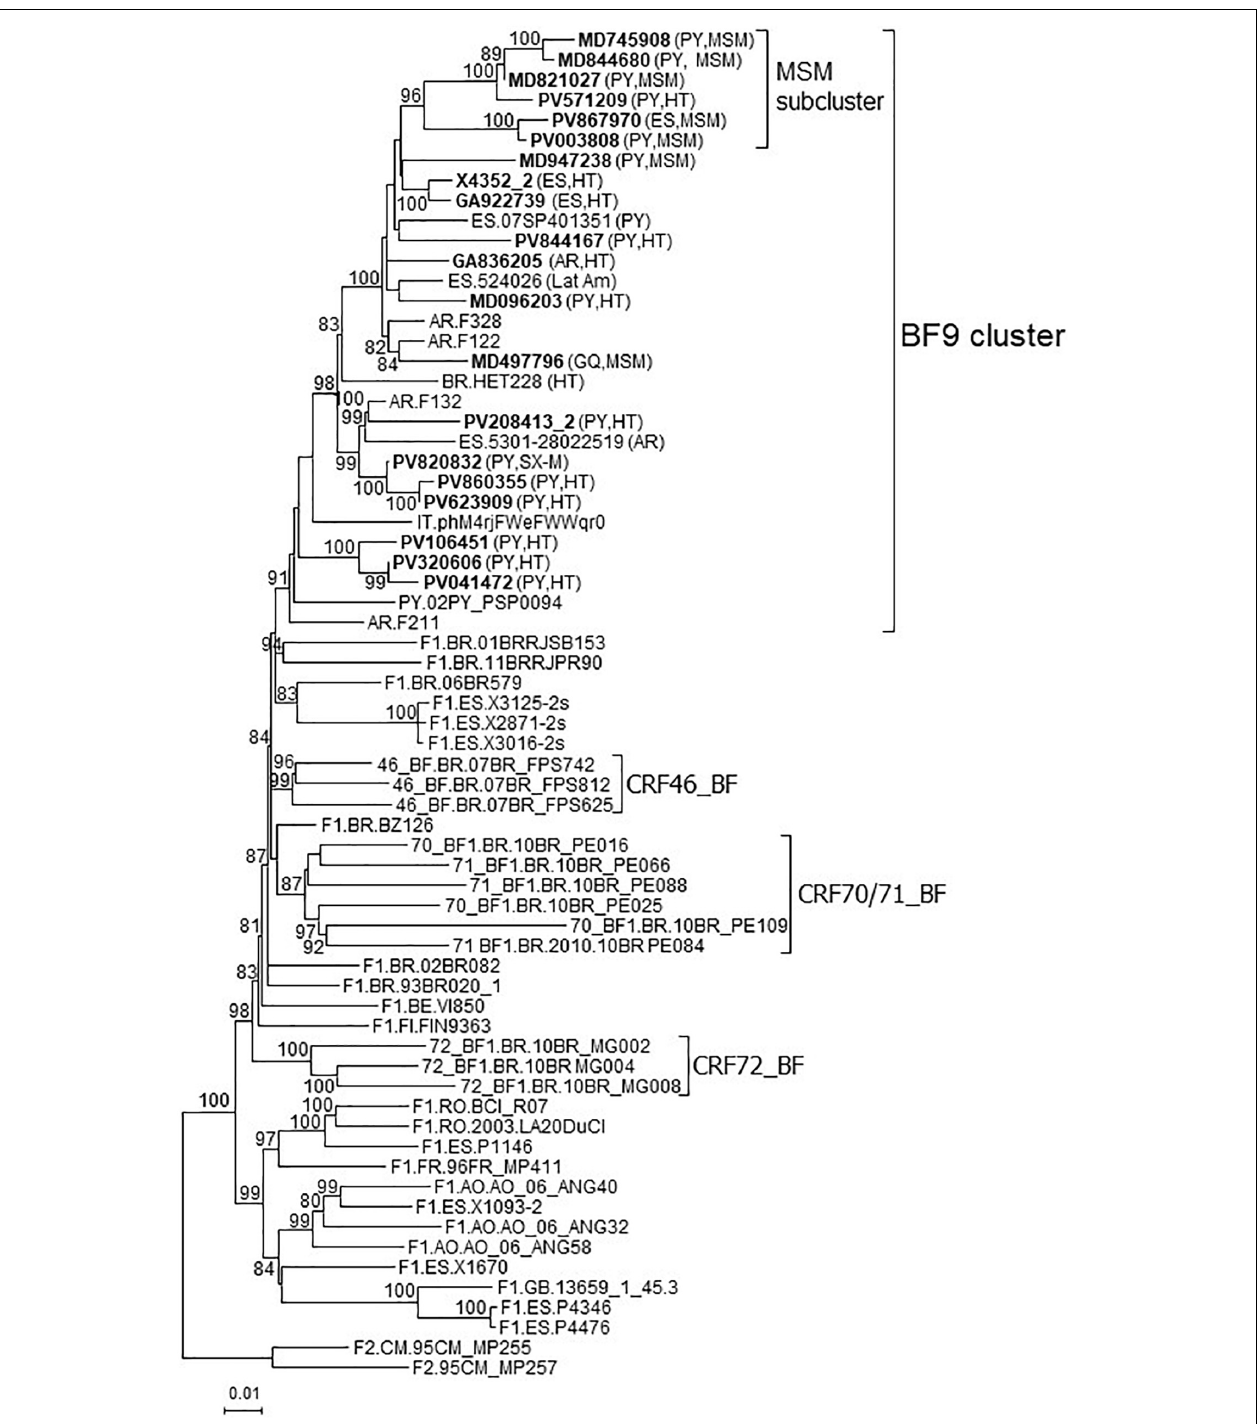
FIGURE 1 | Maximum likelihood tree of Pr-RT sequences of BF9 cluster constructed with IQ-Tree. Sequences used in this analysis were those from the BF9 cluster shown in the tree of Supplementary Figure 1 , constructed with FastTree, plus sequences of F1 subsubtype from different countries and of CRF_BFs that are of nonrecombinant F1 subsubtype in Pr-RT, plus two F2 sequences used as outgroups. Names of sequences obtained by us, all collected in Spain, are in bold type. In database sequences, the country of sample collection is indicated before the virus name with the 2-letter ISO country code. After the names of viruses of the BF9 cluster, the 2-letter ISO code of country of origin of the patient and/or the transmission route, when known, are shown in parentheses. Only ultrafast bootstrap values ≥ 80% are shown. PY: Paraguay; AR: Argentina; ES: Spain; BR: Brazil; IT: Italy; GQ: Equatorial Guinea; Lat Am: Latin America (unknown country); MSM: man who has sex with men; HT: heterosexual; SX-M: male with unspecified sexual acquisition of HIV-1.